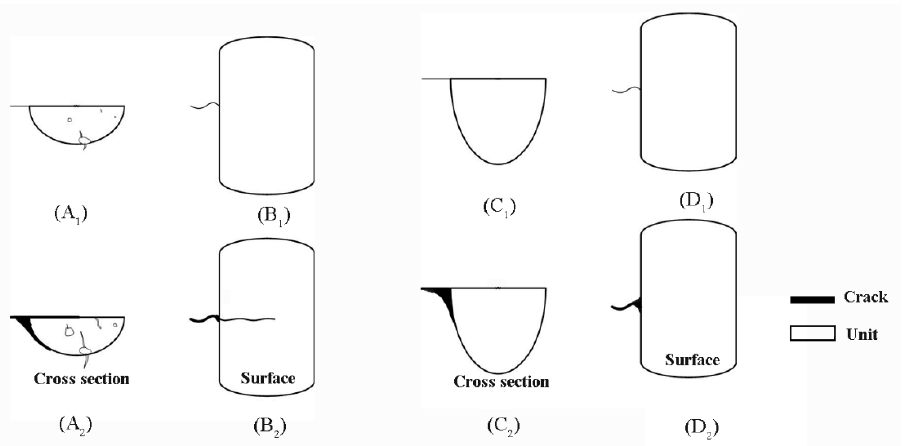
Figure 17. Schematic description for cracks blocked by units with different sizes. ( A 1 – D 1 ) before thermal cycles; ( A 2 – D 2 ) after thermal cycles. thermal cycles; ( A 2 – D 2 ) after thermal